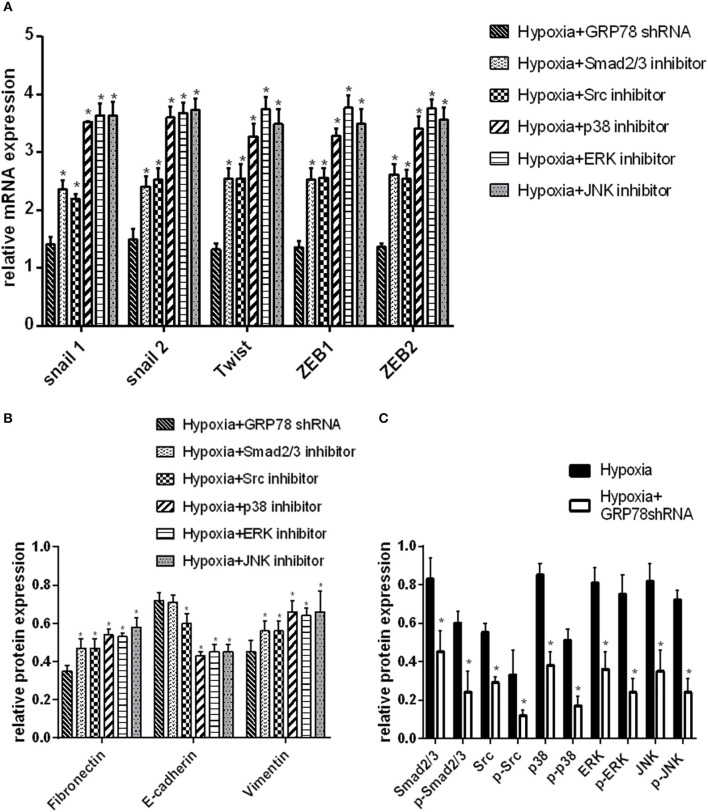
GRP78 is the upper reaches of the Smad2/3, Src and MAPK pathways in hypoxia-induced EMT in A549 cells. (A) The mRNA relative value (control group) of EMT transcription factors is plotted (mean ± SD in three separate experiments). *P < 0.05, compared with EMT transcription factors in A549 cells under hypoxia condition separately inhibited by Smad2/3, Src, p38, ERK, and JNK inhibitors, the expression is higher than that in GRP78 knockdown A549 cells under hypoxia. (B) The protein relative value (GAPDH) of EMT markers was examined by Western blot analysis and plotted (mean ± SD in three separate experiments). *P < 0.05, compared with EMT markers of A549 cells under hypoxia condition separately inhibited by Smad2/3, Src, p38, ERK, and JNK inhibitors, the expression is higher than that in GRP78 knockdown A549 cells in the hypoxia. (A,B) indicate that the inhibition effect of GRP78 silencing is more powerful than those of the five other inhibitors. (C) The protein relative values (GAPDH) of Smad2/3, Src, p38, ERK, JNK, and their phosphorylated forms were examined by Western blot analysis and plotted (mean ± SD in three separate experiments). *P < 0.05, compared with A549 cells under hypoxia, the expression levels of Smad2/3, Src, p38, ERK, JNK, and their activation forms decrease compared with those in GRP78 knockdown A549 cells under hypoxia. After GRP78 silencing, the expression and activation of these proteins are inhibited significantly.